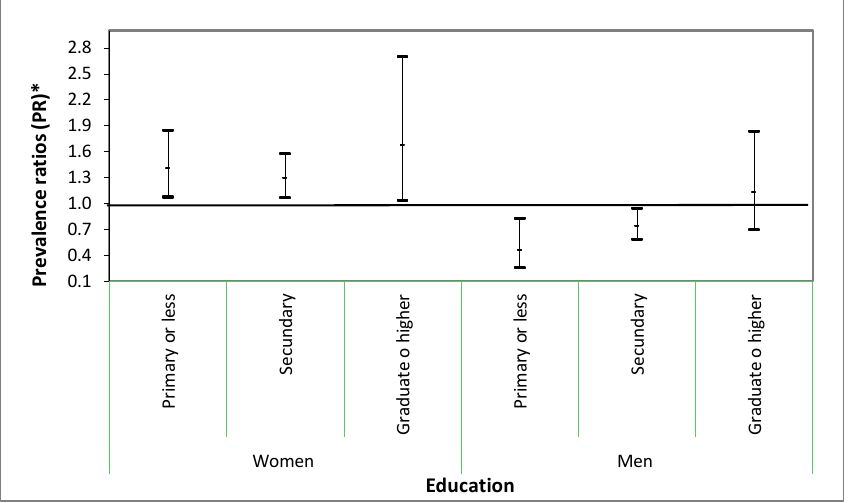
Figure 1. Prevalence ratios (PR) * and 95% confidence intervals of obesity for place of birth according